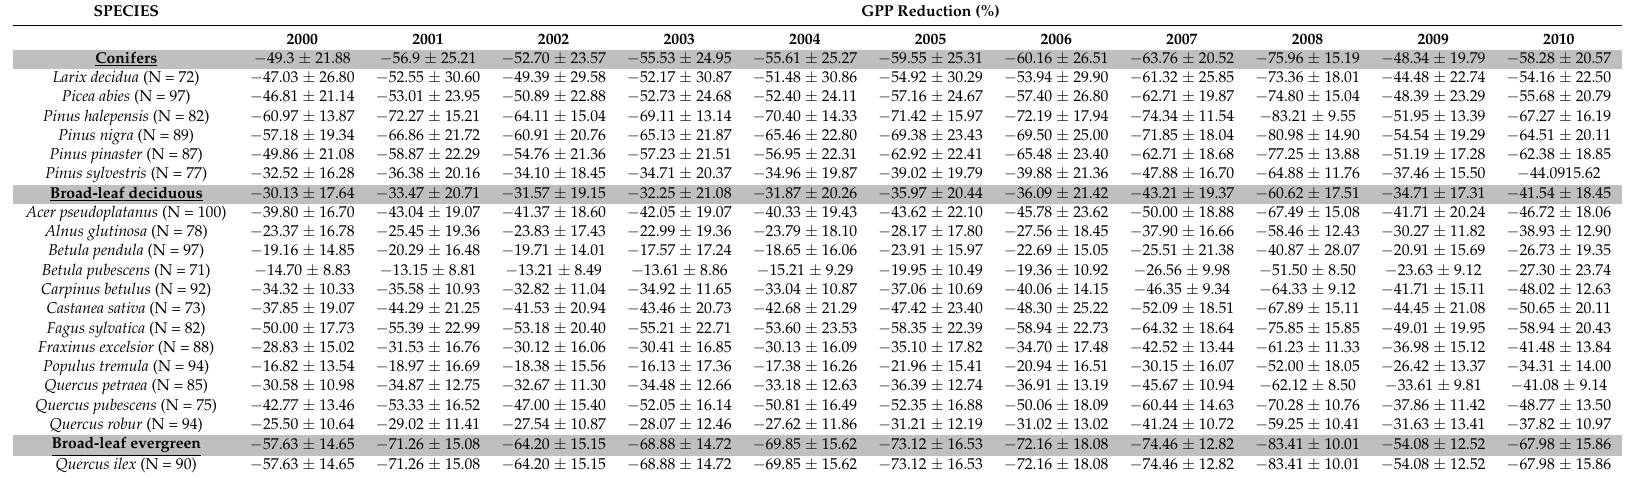
Table 3. Species-specific GPP reduction (%) due to mTVWI over the time period 2000–2010 ( ± standard